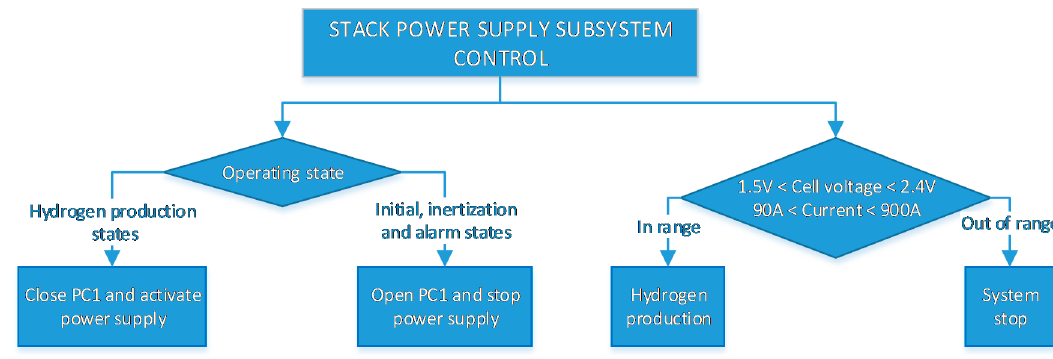
Figure 5. PEM electrolyzer control flow diagram: stack power supply subsystem.